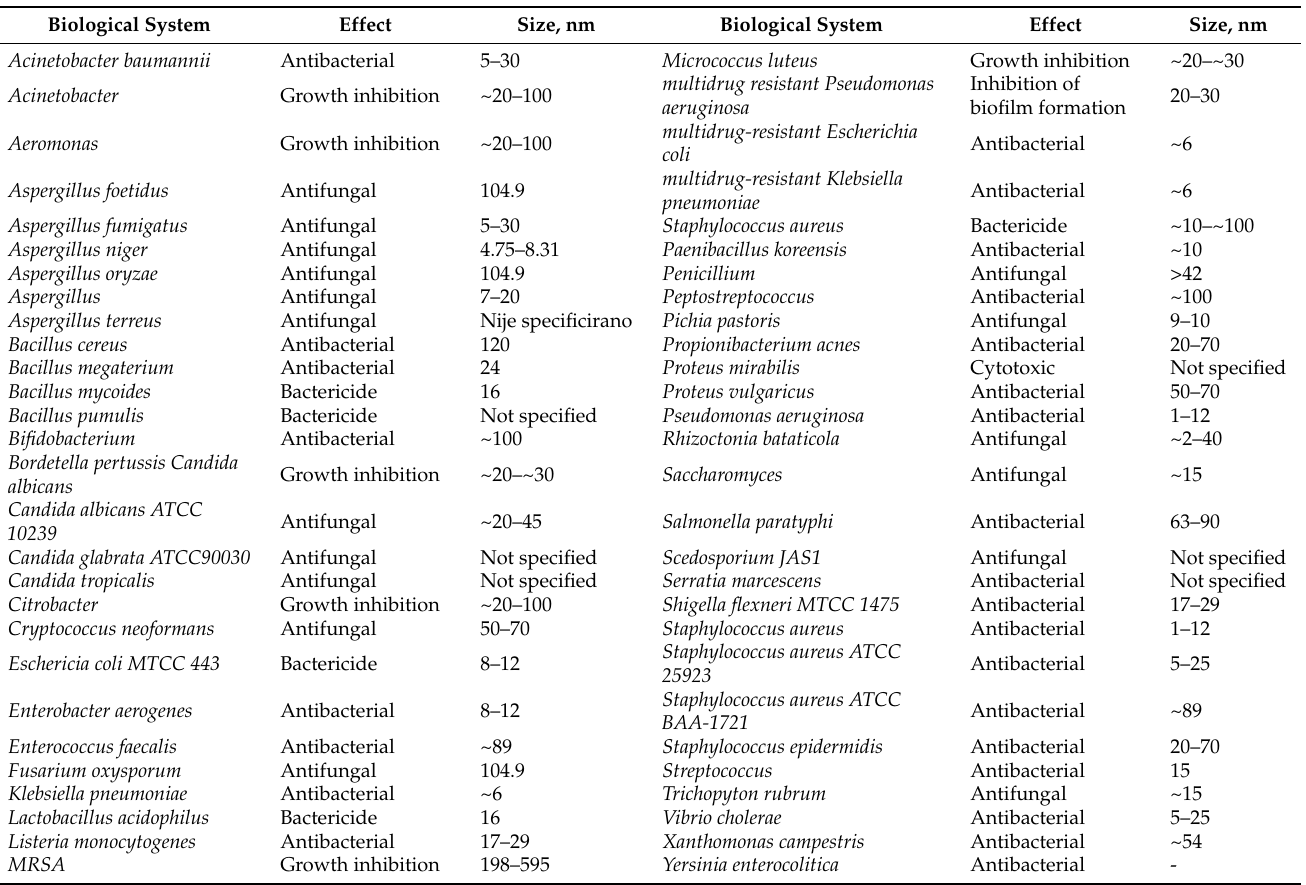
Table 3. Antimicrobial activity of silver nanoparticles on microorganisms [3,9,32].